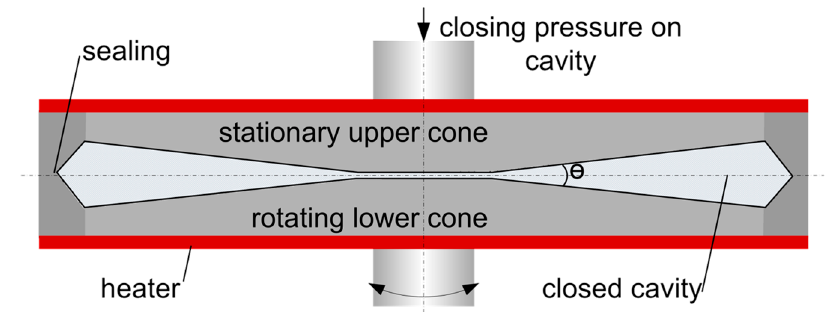
Figure 2. Closed cavity rheometer used for rheological measurements.